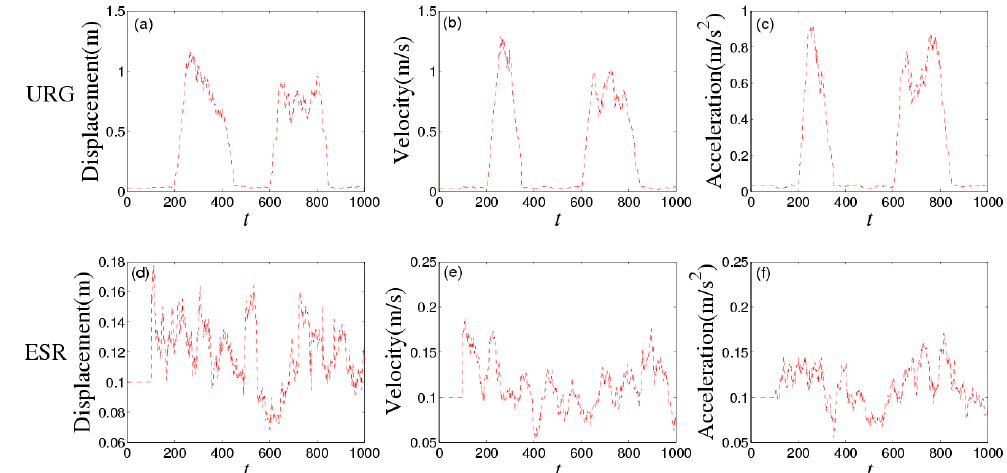
Figure 17. The measurement noise V-C matrix R of the local-filter output of URG and ESR in the third experiment: The R of displacement of ( a ) URG and ( d ) ESR; the R of velocity of ( b ) URG and ( e ) ESR and the R of acceleration of ( c ) URG and ( f ) ESR.